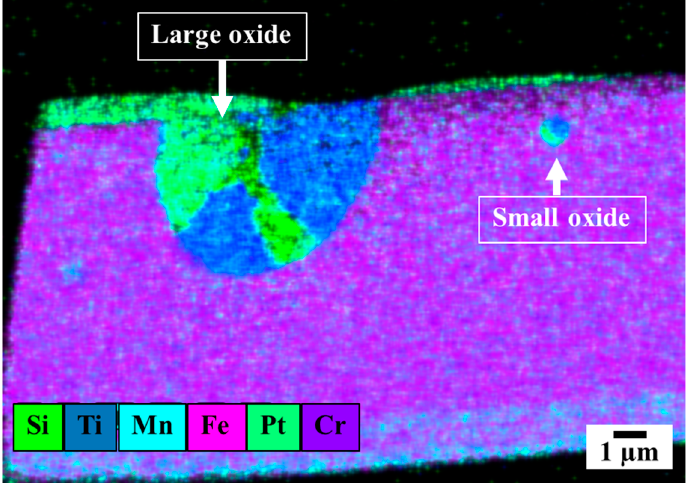
Figure 1. Elemental distributions of the oxide inclusion in the welded metal 2101 joint by EDS-TEM.